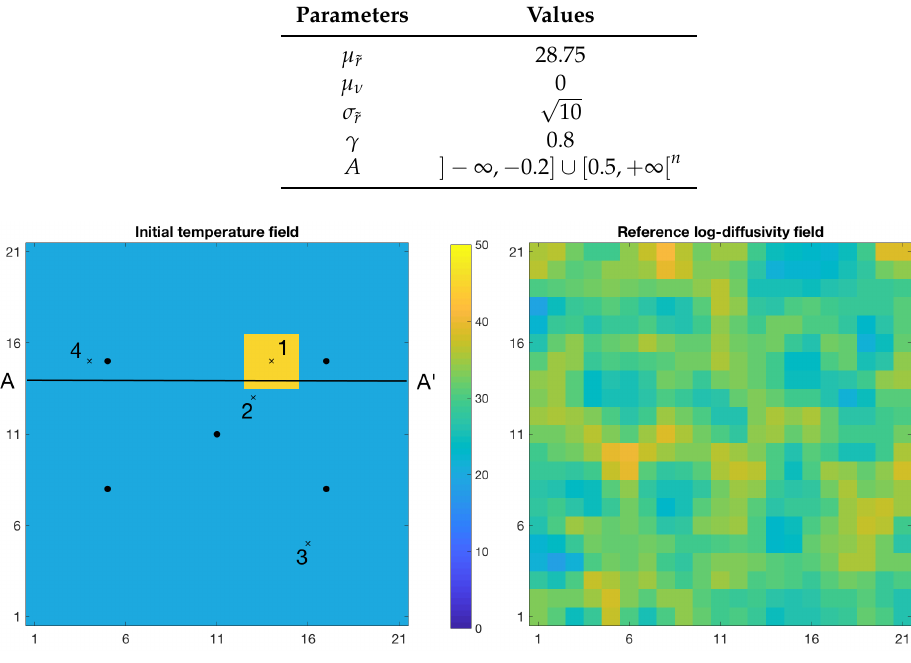
Table 3. Parameter values for the selection-Gaussian initial distribution for the initial temperature prior model.